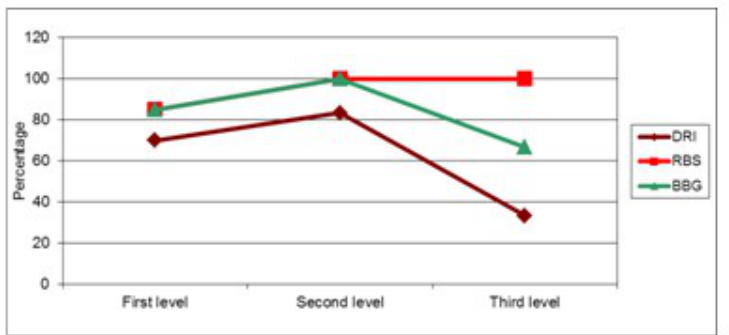
Figure 2. Evaluaton results on the three levels of knowledge structure of three students in a General Chemistry course